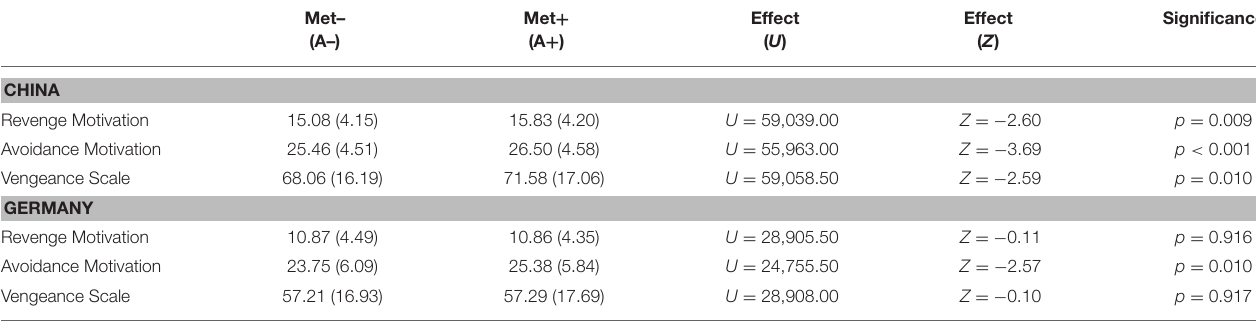
TABLE 3 | Effects of the COMT Val158Met polymorphism (on allele level) on all scales under investigation split by nation. Met– (A–)